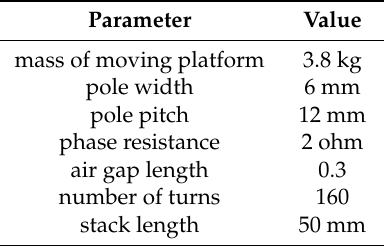
Figure 6. ( a ) Schematic of LSRMs; ( b ) stator and windings; ( c ) stator base and moving platform; and ( d ) LSRM control diagram. Table 1. Major Specifications of LSRMs.